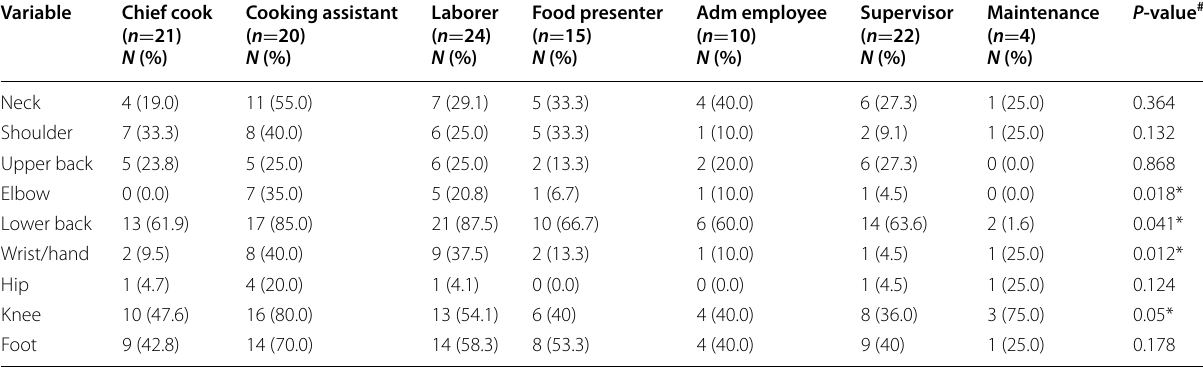
# Chi-square test was used but if (20.0%) of the cells or more have an expected count of less than 5 Fischer’s exact test was used * Statistically significant at P 0.05 ≤